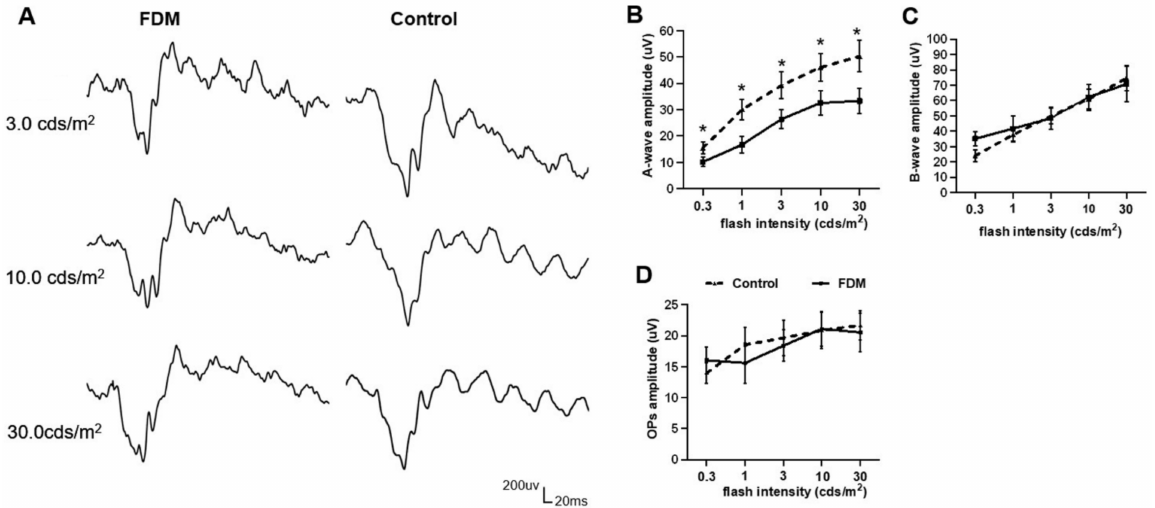
Figure 1. Electroretinography (ERG) in form-deprivation-induced myopia (FDM) and control eyes. ( A ) Representative scotopic ERG responses from FDM and naïve nontreated control eyes in 3.0 cds/m 2 , 10.0 cds/m 2 and 30.0 cds/m 2 . ( B – D ) Statistical data of a-wave amplitude ( B ), b-wave amplitude ( C ) and OPs amplitude ( D ). Mean ± SD, n = 12/group. * p < 0.05. Multiple t